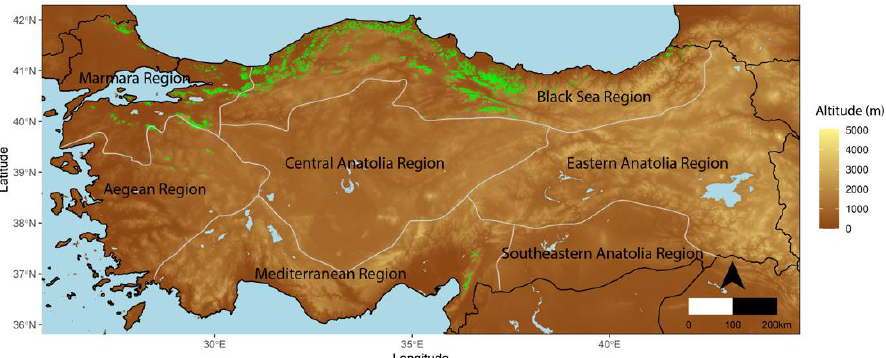
Figure 2. Initial distribution of all pure F. orientalis stand pixels before temporal and spatial masking (shown in green).